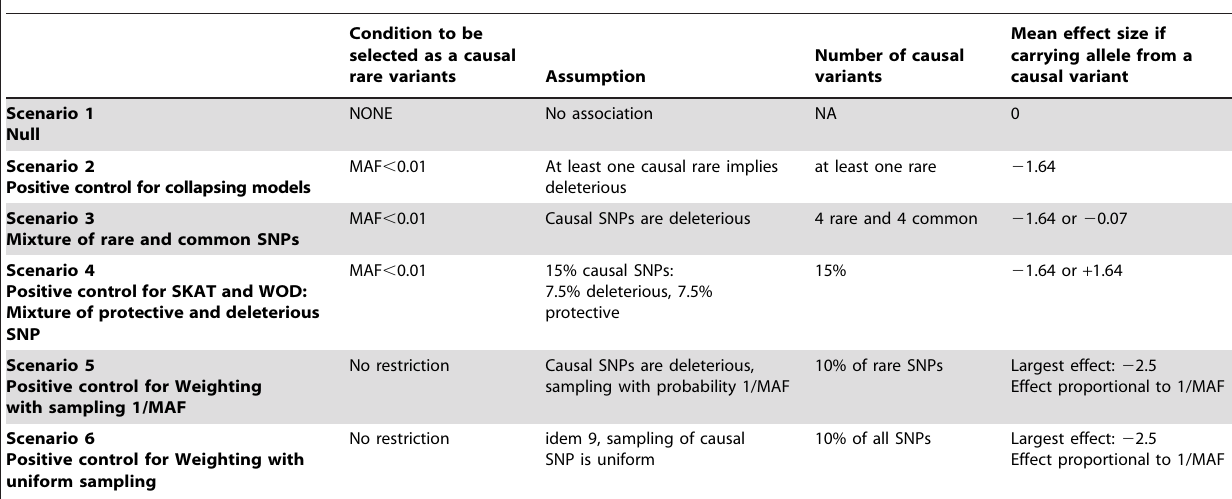
Table 1. Summary of phenotype simulations and hypotheses.